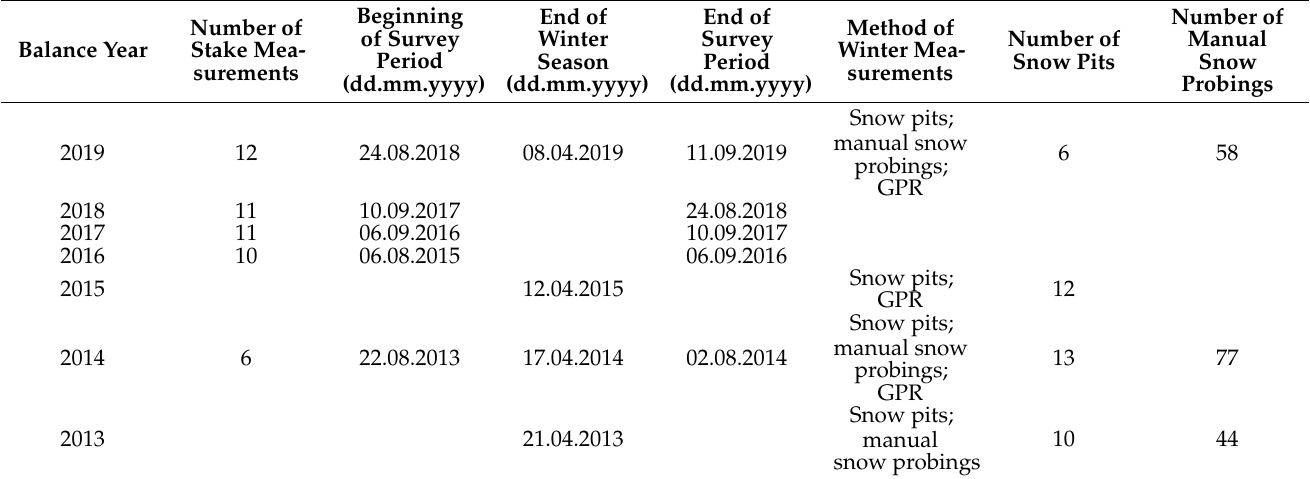
Table 1. Number of measurement sites and dates of field